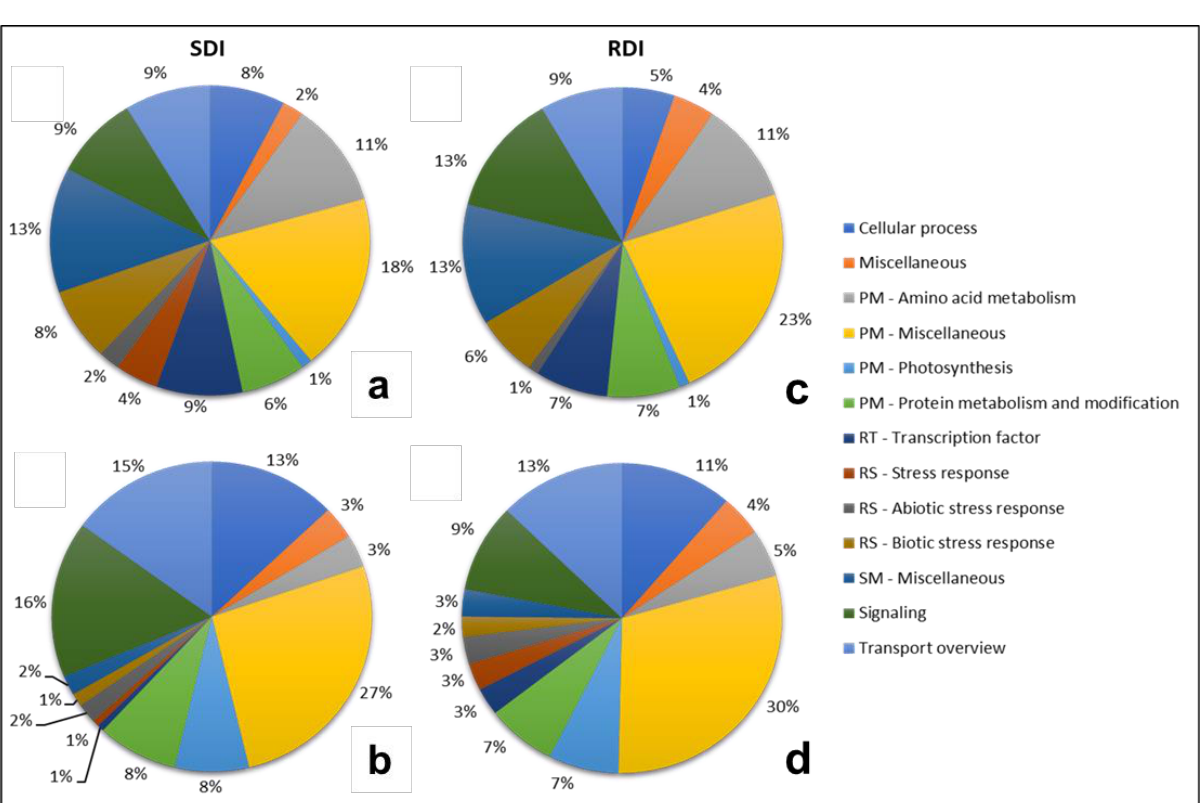
Figure 4. Functional category analysis of significantly regulated DEGs in sustained deficit irrigation (SDI) and regulated deficit irrigation (RDI). Gene expression values were obtained through RNA-seq analysis, and the genes included in these pie charts showed significant differences in expression in SDI and RDI when comparing maturation with véraison . Charts ( a , c ) — upregulated DEGs; ( b , d ) — downregulated DEGs. PM — primary metabolism; RT — regulation of transcription; RS — response to stress; SM — secondary metabolism.